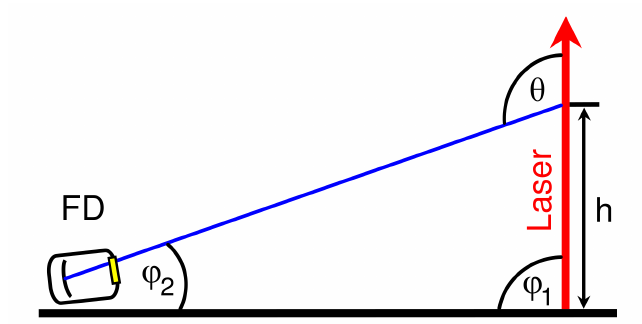
tory: in figure 3, the geometrical layout of the Pierre Auger Observatory Fluorescence Detector - vertical distant laser facility is schematized.